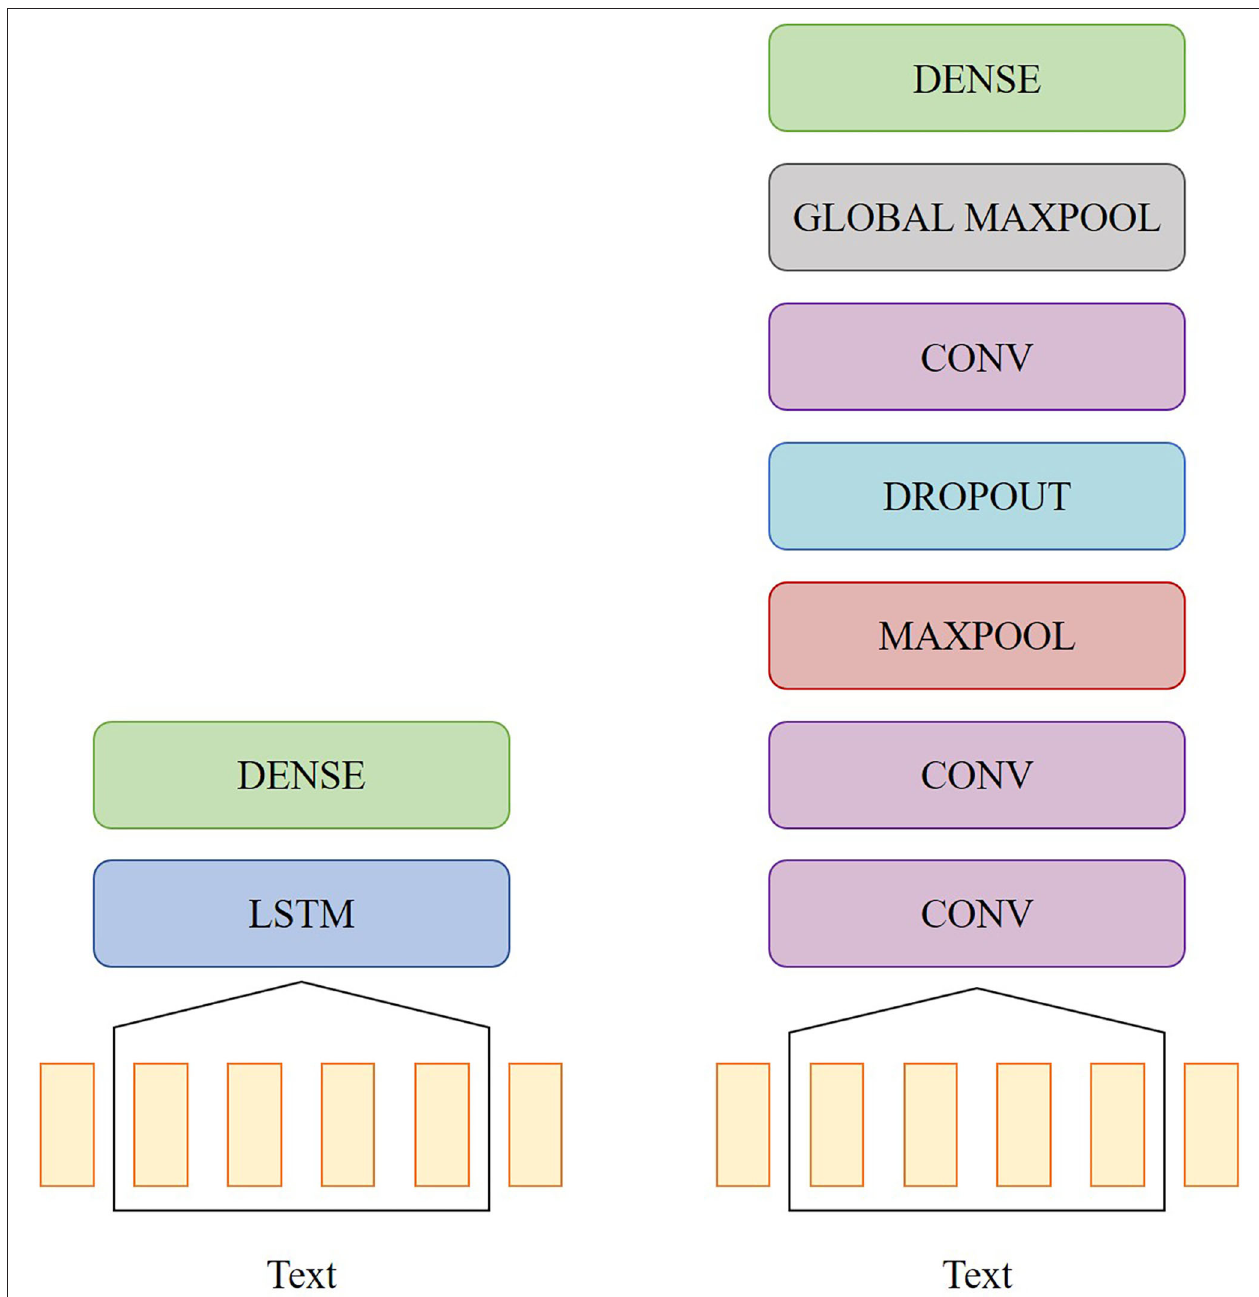
FIGURE 1 | Diagrams of the network topology for the LSTM model (left) and the CNN model